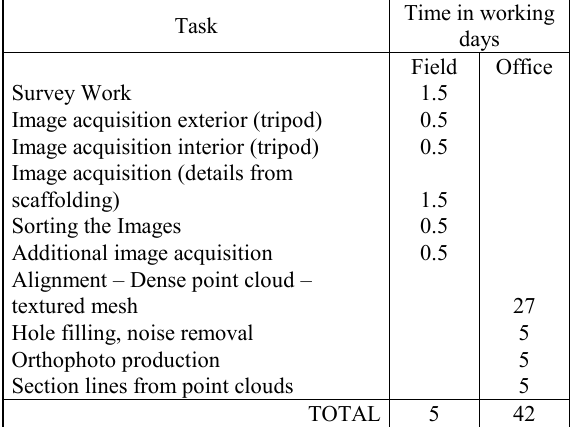
Table 1: Time estimation for data acquisition and processing